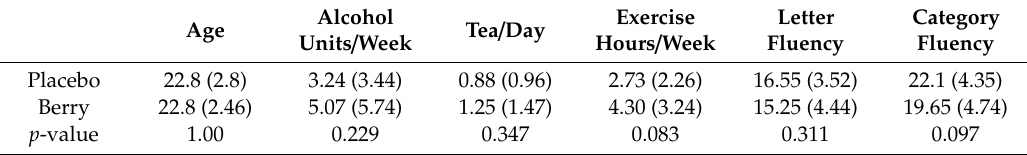
Table 1. Demographic details by intervention group standard deviation in parenthesis.